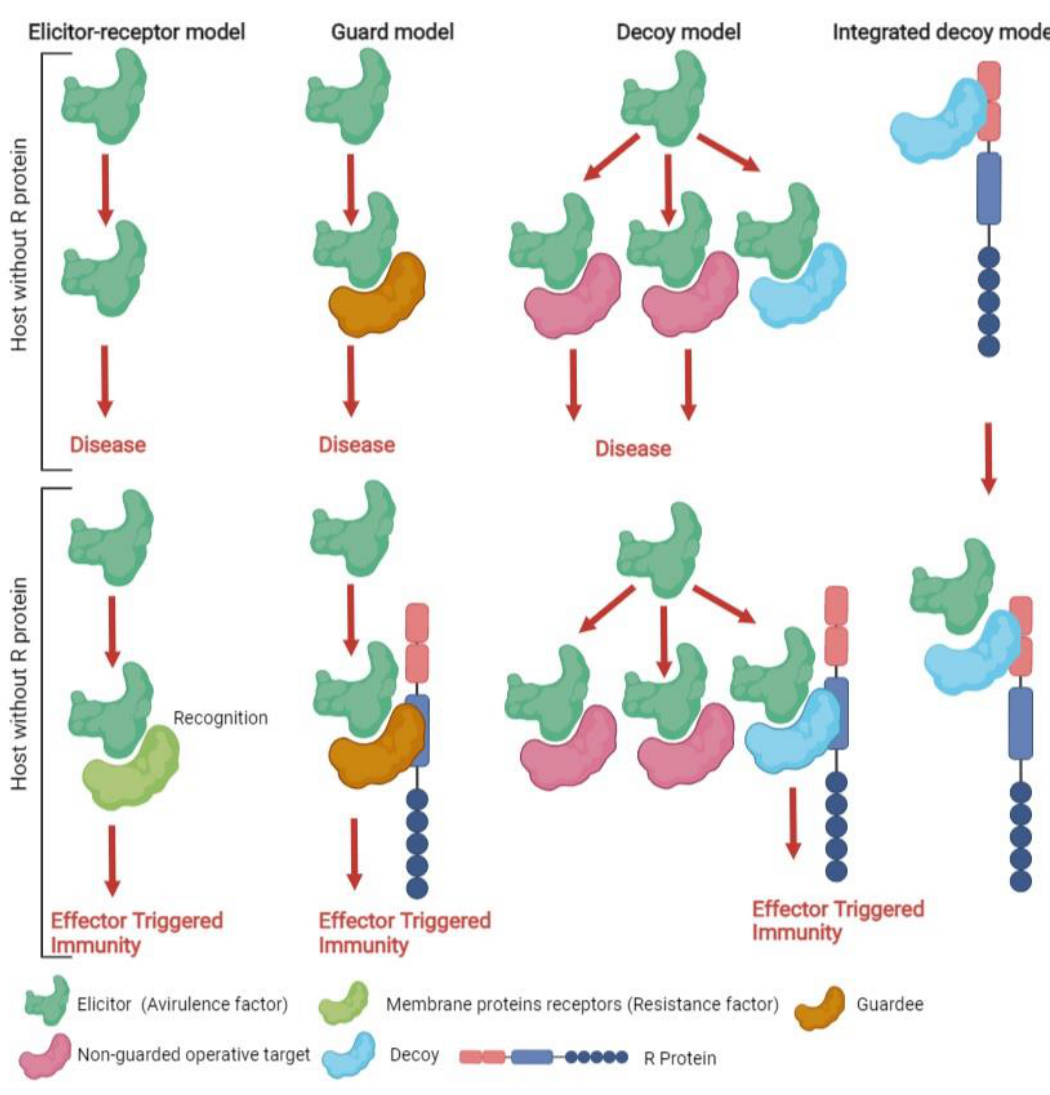
Figure 2. Comparison of four proposed models of AVR recognition by R proteins.